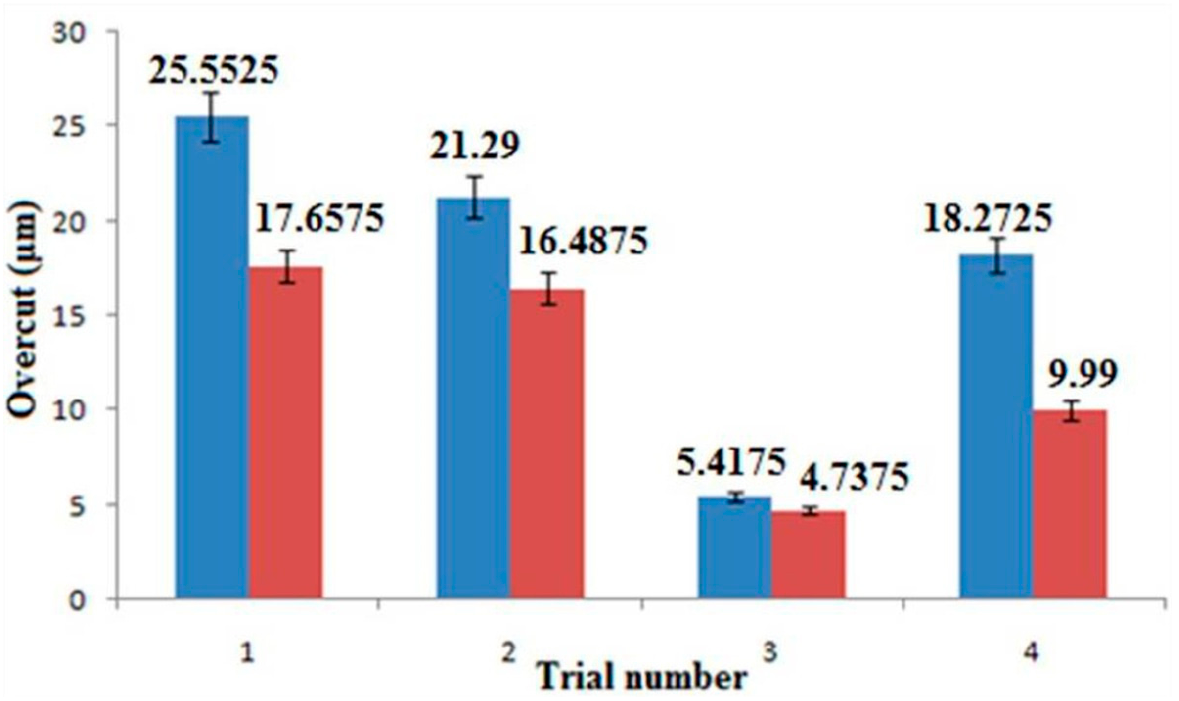
Figure 7. Comparison graph for bare tool and additive tool on